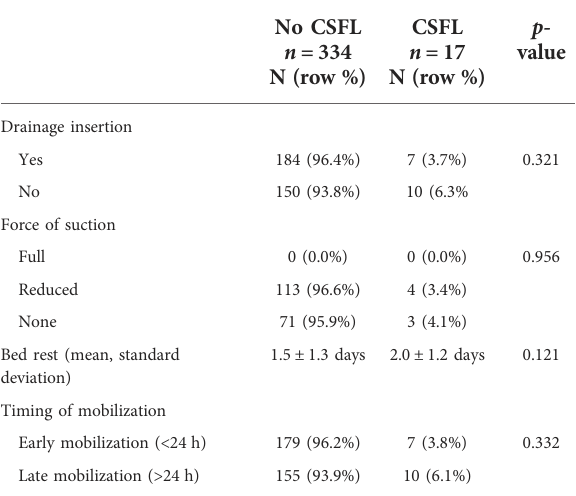
TABLE 3 Perioperative factors.